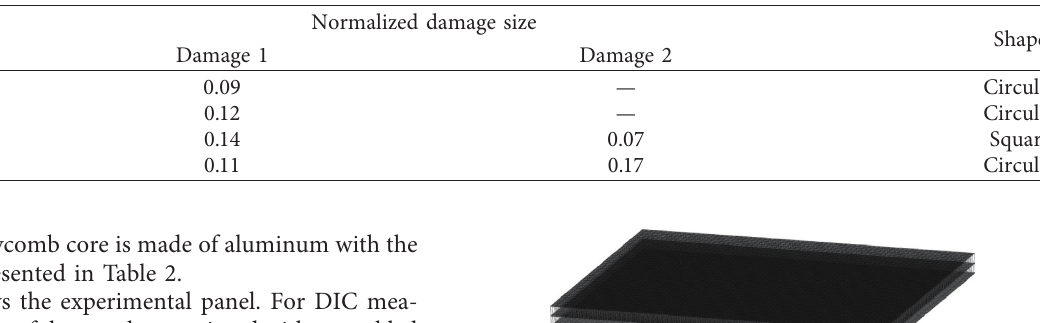
Figure 4: Experimental panel with speckle pattern. Table 3: Experimental damage cases.